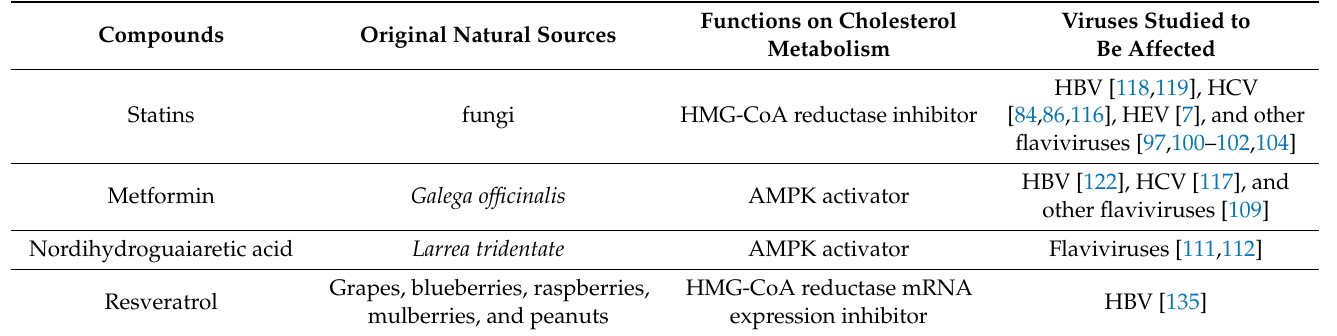
Figure 3. Chemical structures of selected natural compounds with inhibitory activities on cholesterol biosynthesis. ( a ) lovastatin; ( b ) metformin; ( c ) nordihydroguaiaretic acid; ( d ) salvianolic acid C; ( e ) curcumin; ( f ) resveratrol; ( g ) cinnamic acid; ( h ) berberine. Table 2. Examples of natural cholesterol-lowering compounds tested to exhibit antiviral activities.